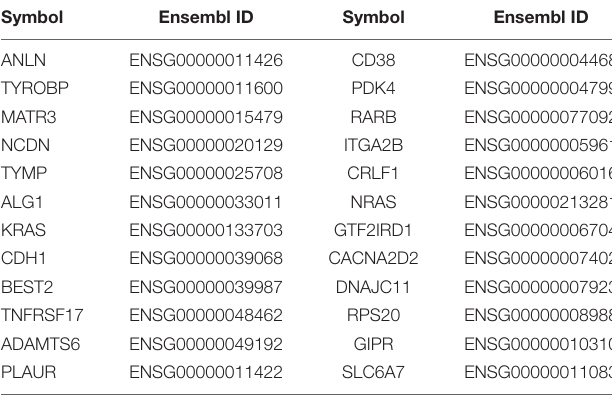
TABLE 2 | Predicted susceptible genes by random